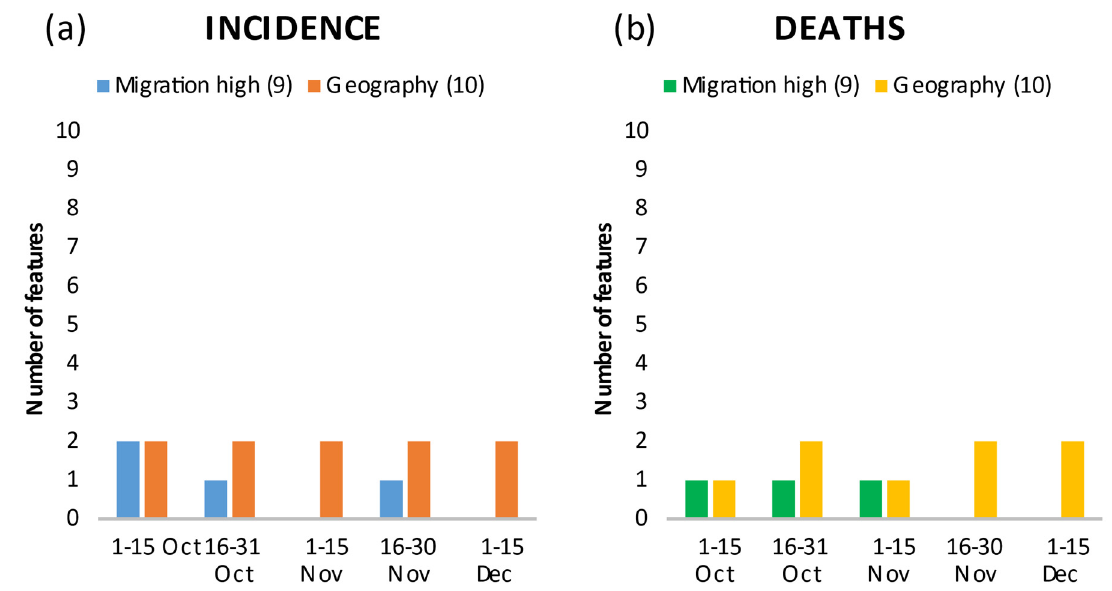
Figure 6. Number of features in the top 20 showing the relationship between care need and health, and incidence ( a ) and death rates ( b ) by time period.